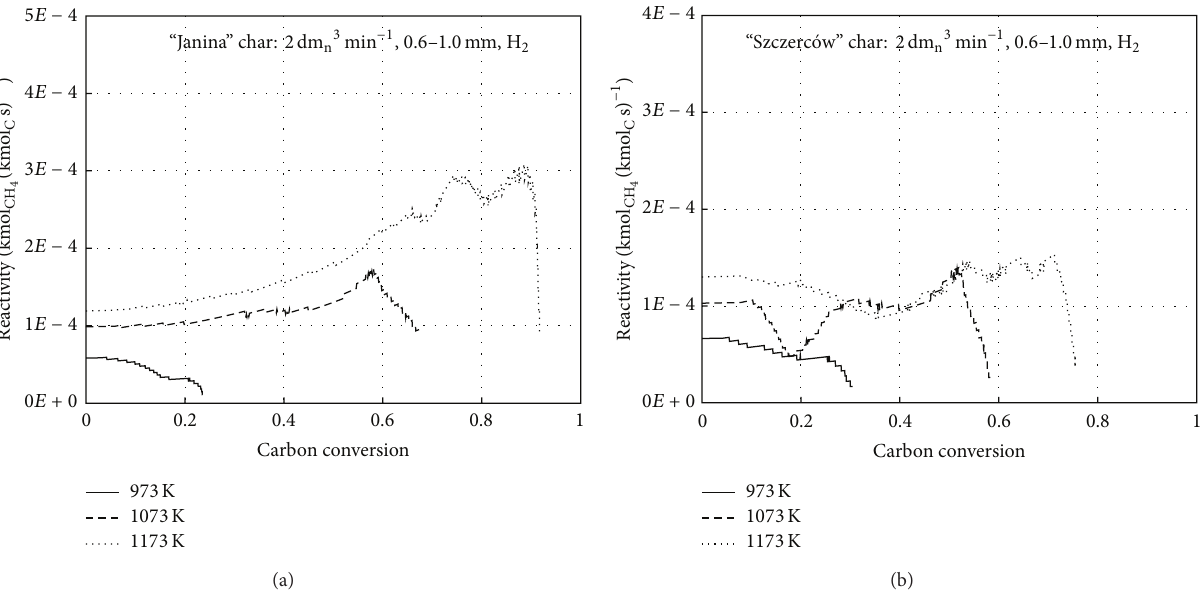
Figure 5: Hydrogasification reactivity versus carbon conversion time for (a) “Janina” and (b) “Szczerc´ow” char.